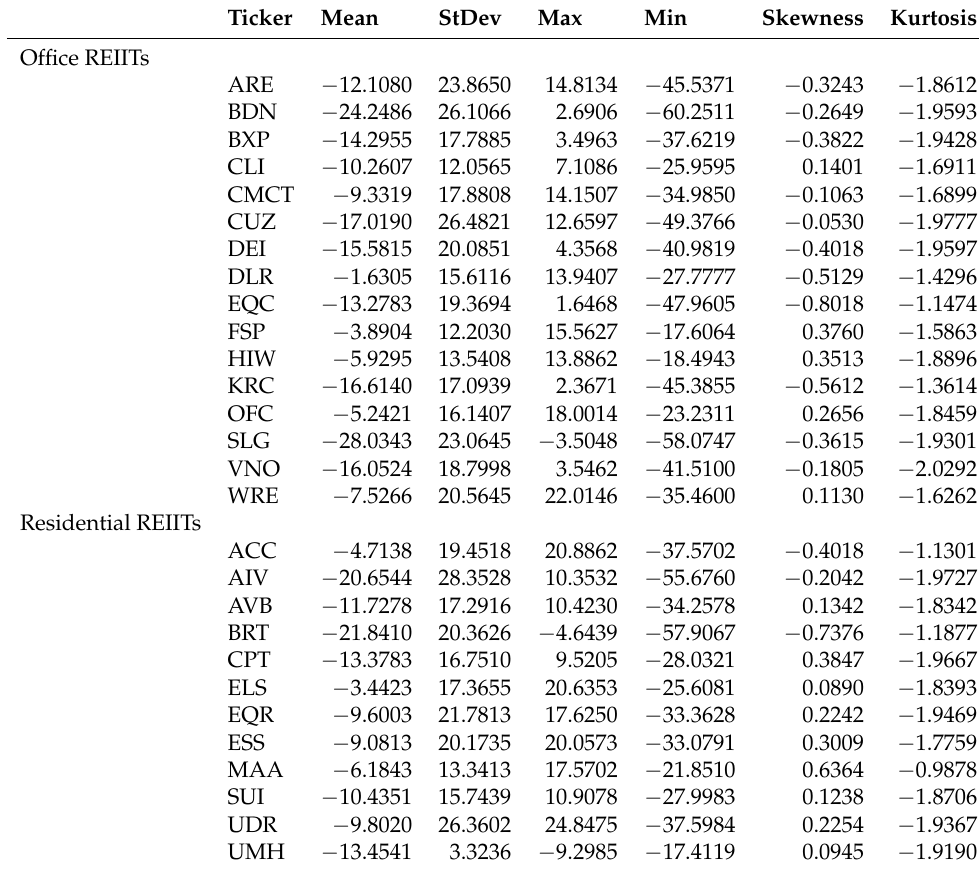
Table A3. Descriptive Statistics for Office and Residential REITs Quarterly Returns, the GFC Period.